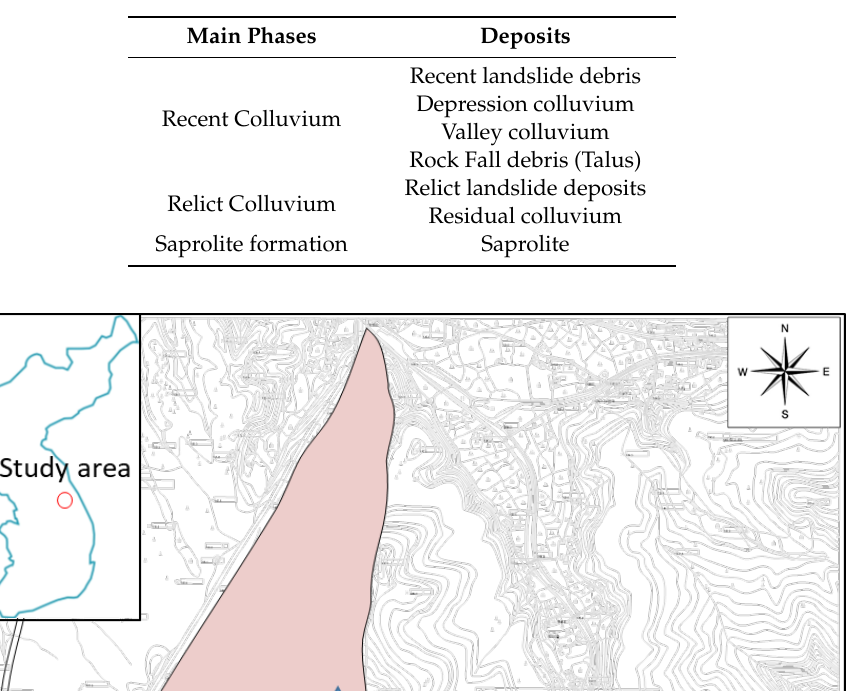
Table 1. Classification of regolith (after [40]).